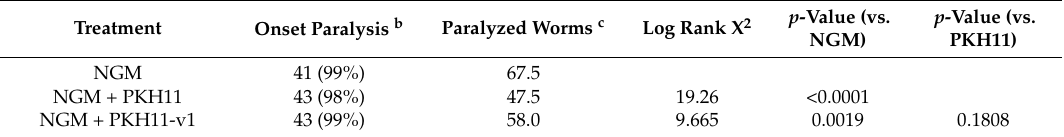
Table 6. Effects of the PKH11 and PKH11-v1 treatments at 0.1 µ g/mL on CL4176 paralysis and statistical analyses of paralysis curves a